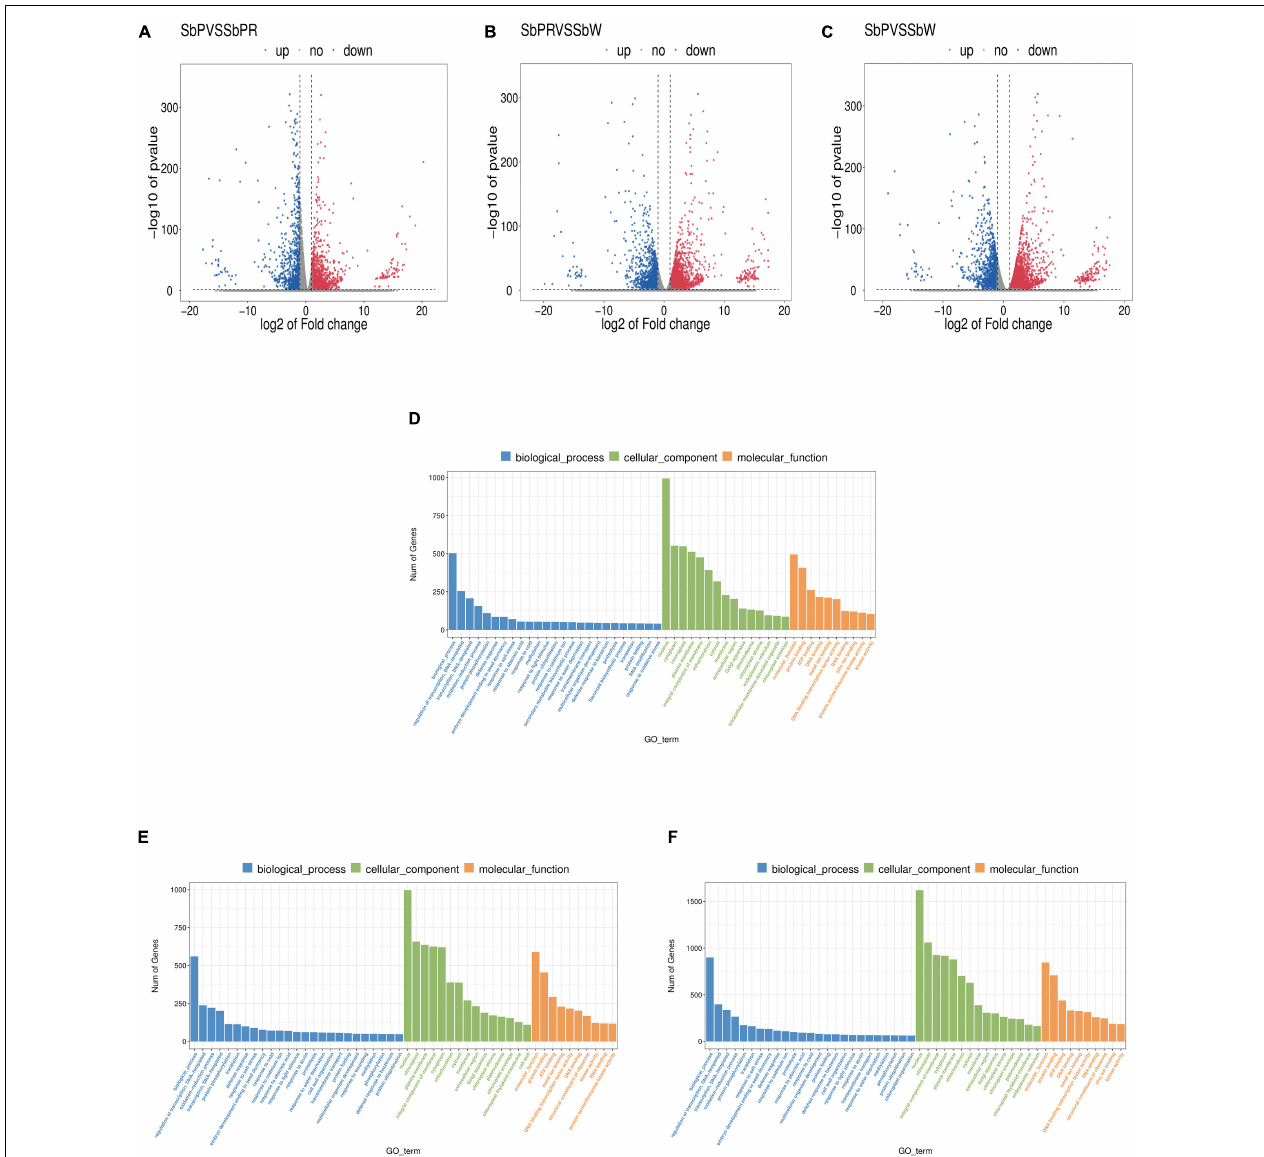
FIGURE 3 | Transcriptome analysis of genes in SbW, SbPR, and SbP. (A–C) The volcano plot indicates the differential gene expression levels among SbW, SbPR, and SbP. Blue dots represent down-regulated DEGs; red spots represent up-regulated DEGs; and gray represents non-DEGs. (D–F) GO enrichment of the differential genes in SbW, SbPR, and SbP. SbW: white flower at the blooming stage; SbPR, purple-red flower at the blooming stage; SbP, purple flower at the blooming stage.